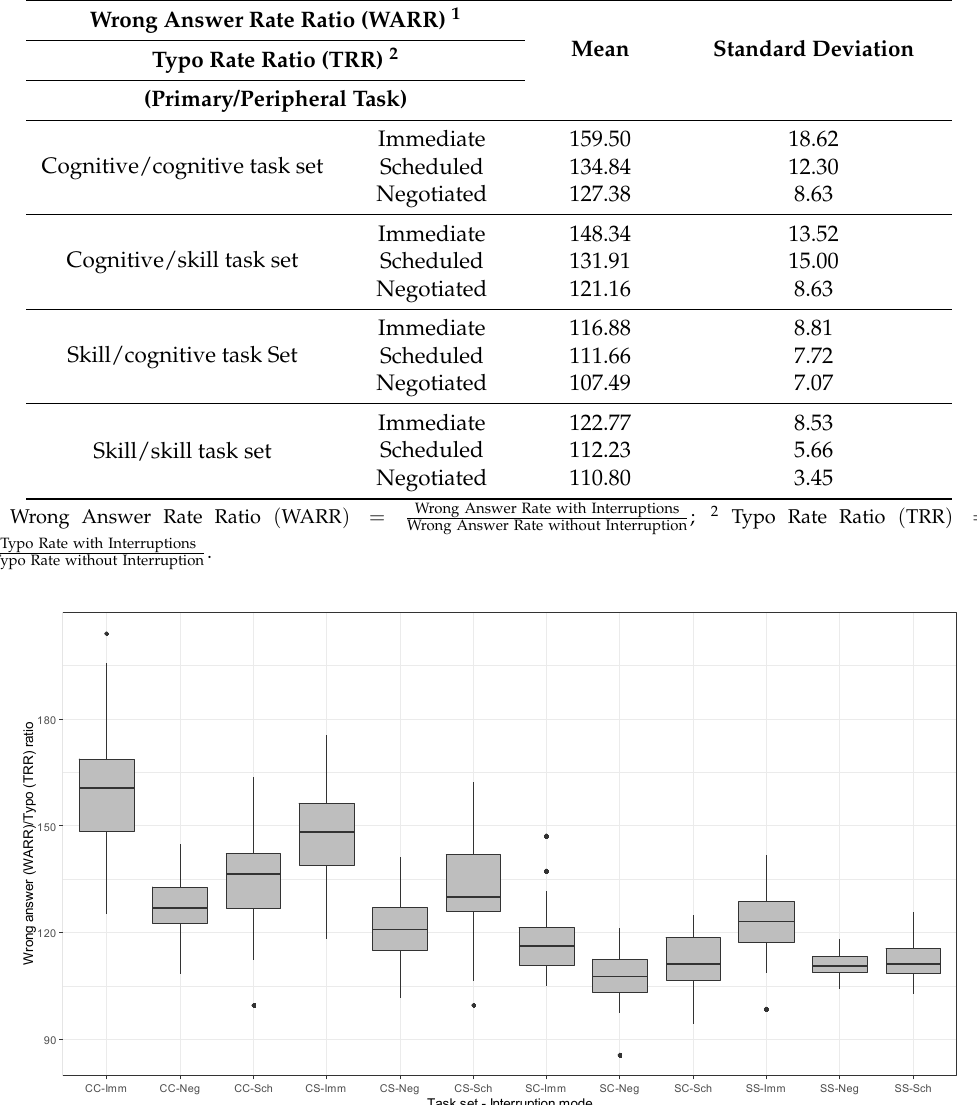
Table 6. Descriptive statistics of typo rate ratio and wrong answer rate ratio under each task set.